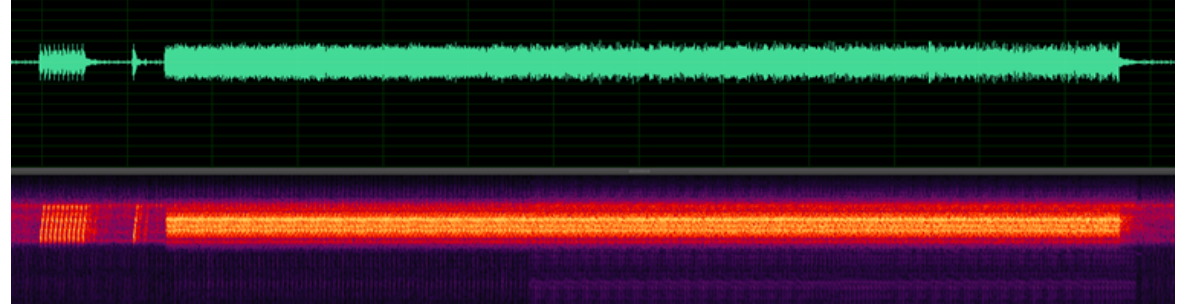
Figure 5. Time-frequency diagram of DSSS